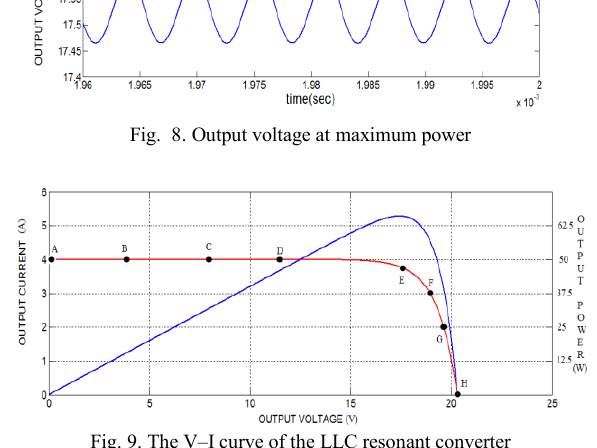
Fig. 7. Output Current at maximum power operating in region 2